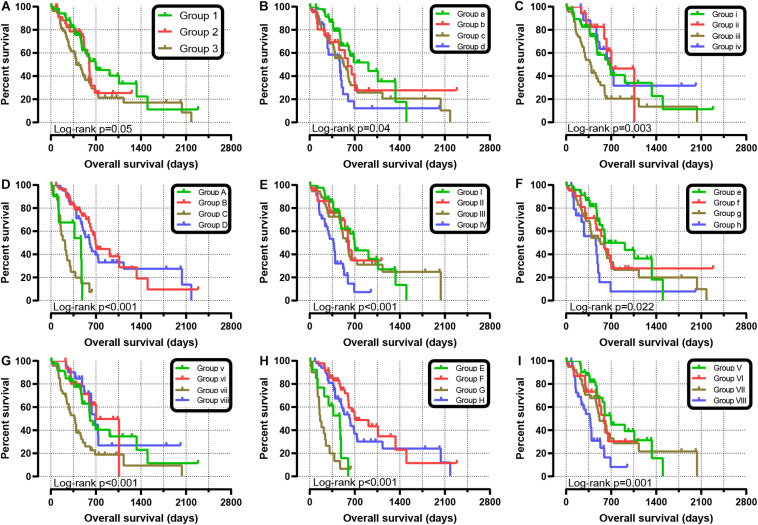
Joint-effect survival analysis for overall survival of patients with pancreatic ductal adenocarcinoma. (A) Combination of SKA1 and SKA3. Combination of SKA1 and prognosis-related clinical factors: (B) histologic grade; (C) radiation therapy; (D) targeted molecular therapy; (E) radical resection. Combination of SKA3 and prognosis-related clinical factors: (F) histologic grade; (G) radiation therapy; (H) targeted molecular therapy; (I) radical resection.